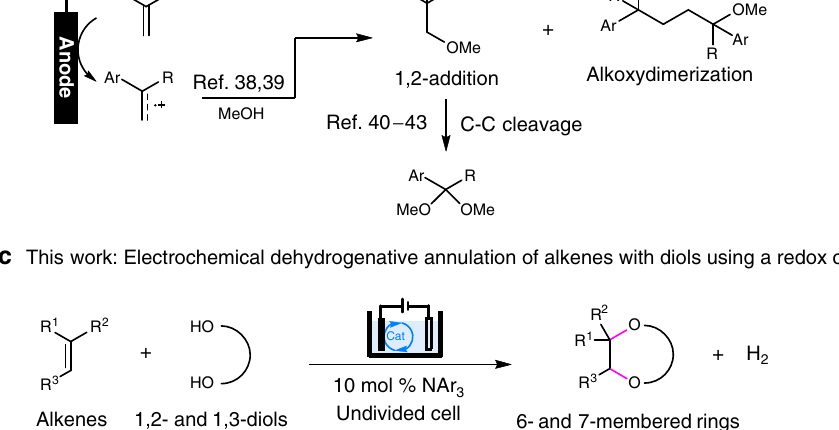
Fig. 1 Reaction design. a Selected bioactive molecules containing the 1,4-dioxane moiety. b Oxidation of styrenyl alkenes via direct electrolysis. c Synthesis of O-heterocycles via annulation reactions of alkenes with